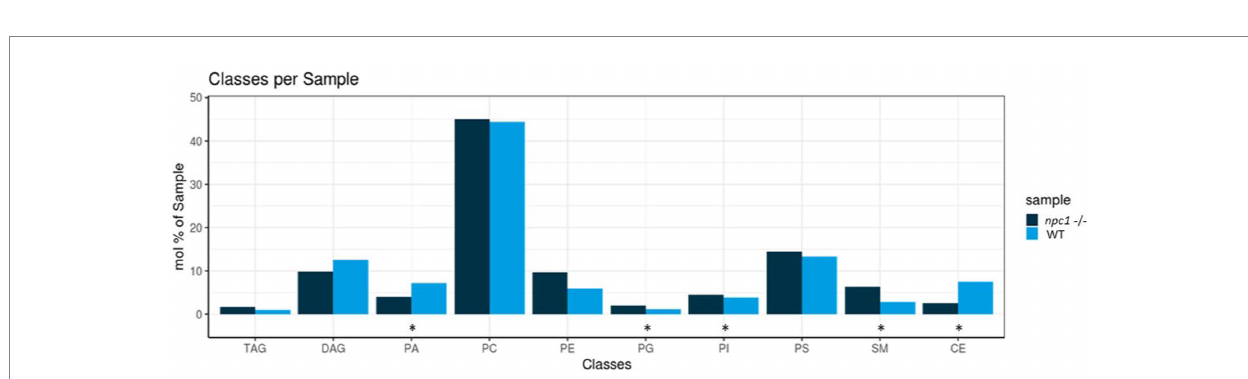
FIGURE 11 Lipidomic analysis of 10 different lipid classes: TAG (triacylglycerol), DAG (diacylglycerol), PA (phosphatidate), PC (Phosphatidylcholine), PE (phosphatidylethanolamine), PG (phosphatidylglycerol), PI (phosphatidylinositol), PS (phosphatidylserine), SM (sphingomyelin) and CE (cholesteryl esters) between wt (healthy) and npc1 − / − (disease) revealed statistically significant percentage differences in PA (value of p = 0.036), PG (value of p = 0.0055), PI (value of p = 0.038), SM (value of p = 0.002), and CE (value of p = 0.02). Statistically significant data in the graphs is indicated with a